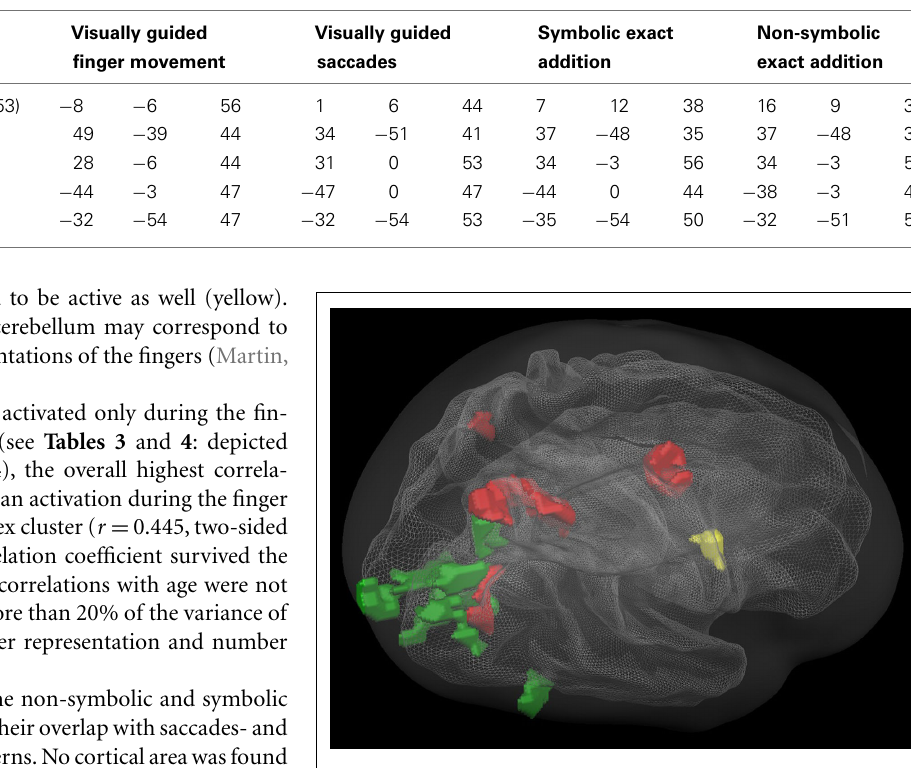
FIGURE 5 | Overlapping regions between specific non-symbolic numerical (magnitude comparison and exact addition) and non-numerical tasks using inclusion and exclusion analyses: regions commonly activated during all tasks (red); regions commonly activated during the non-symbolic number processing tasks and the finger movement task, but not the saccades task (yellow); regions commonly activated during the non-symbolic number processing tasks and the saccades task, but not the finger movement task (green). All group activations are projected onto aTalairach child template. All clusters are significant at a cluster-threshold corrected p -value of 0.05.